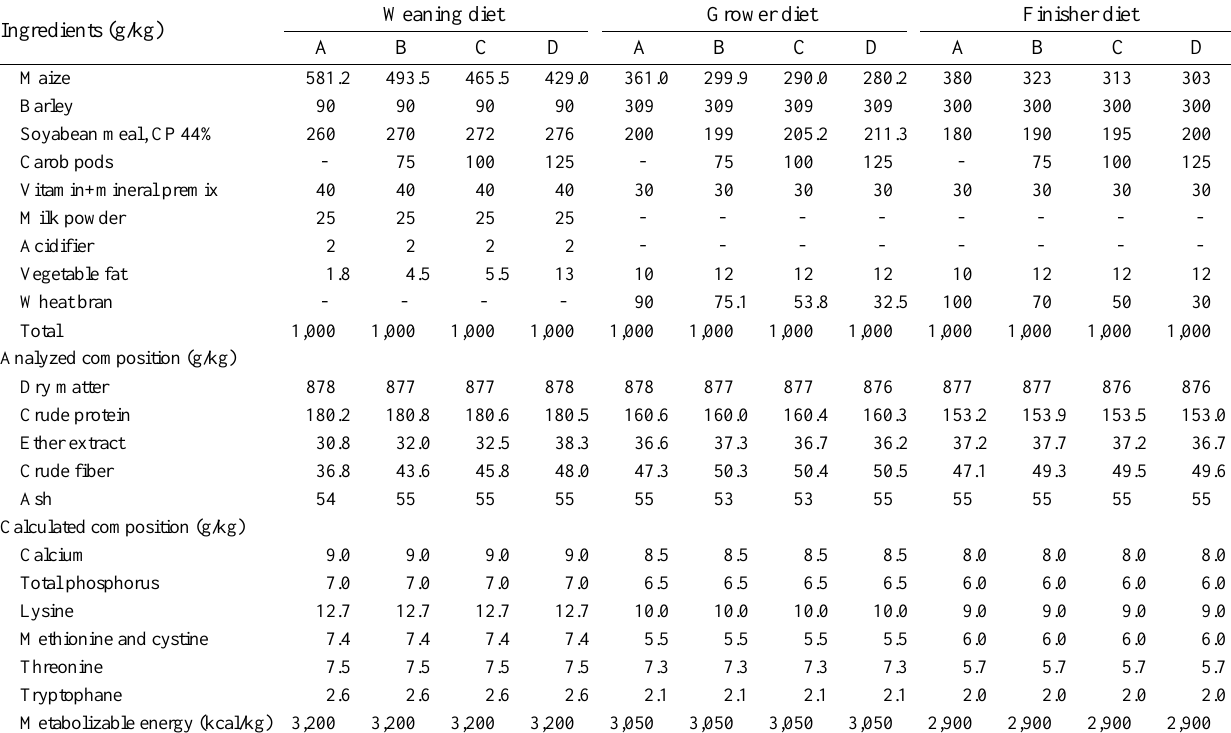
Table 1. Ingredients and chemical composition of the weaning, grower and finisher experimental diets Ingredients (g/kg)